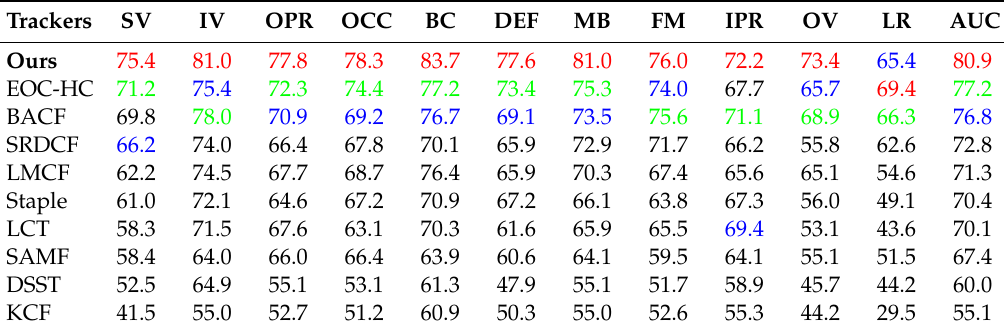
Table 4. Overlap accuracy and average accuracy of representative ten trackers in 11 di ff erent attributes. Red, green, and blue, respectively, represent the top three trackers.